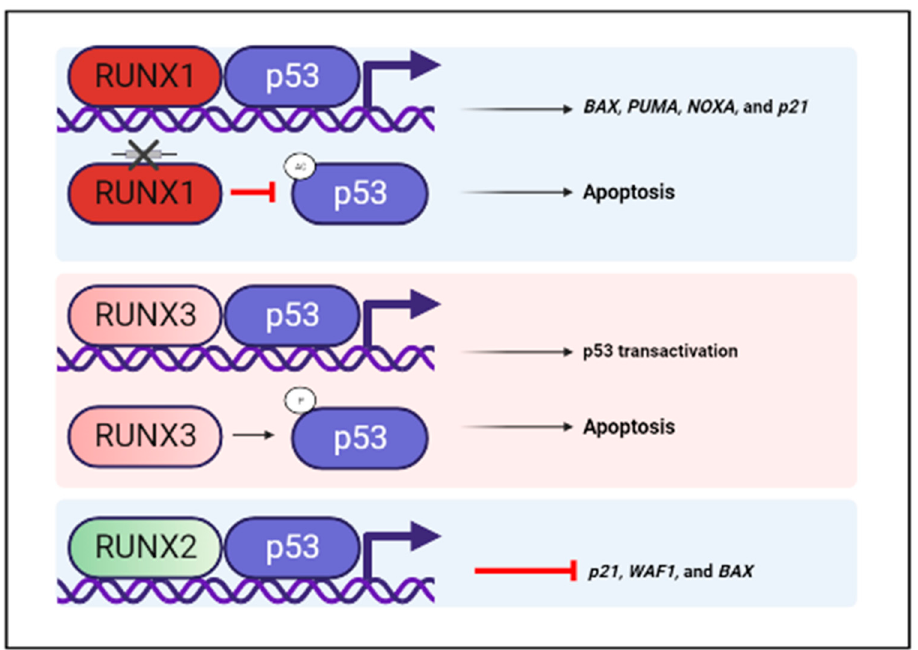
Figure 4. RUNX-p53 crosstalk and regulation of the DNA damage response. Both RUNX1 and RUNX3 form a complex with p53 and promote the transactivation of p53 target genes upon exposure to DNA damage. In addition, RUNX1 stimulates the acetylation of p53 at Lys-373/382, while RUNX3 promotes p53 phosphorylation at the serine 15 residue. The interaction of RUNX2 with p53, on the other hand, suppresses the transactivation of p53 target genes in response to the chemotherapeutic adriamycin.